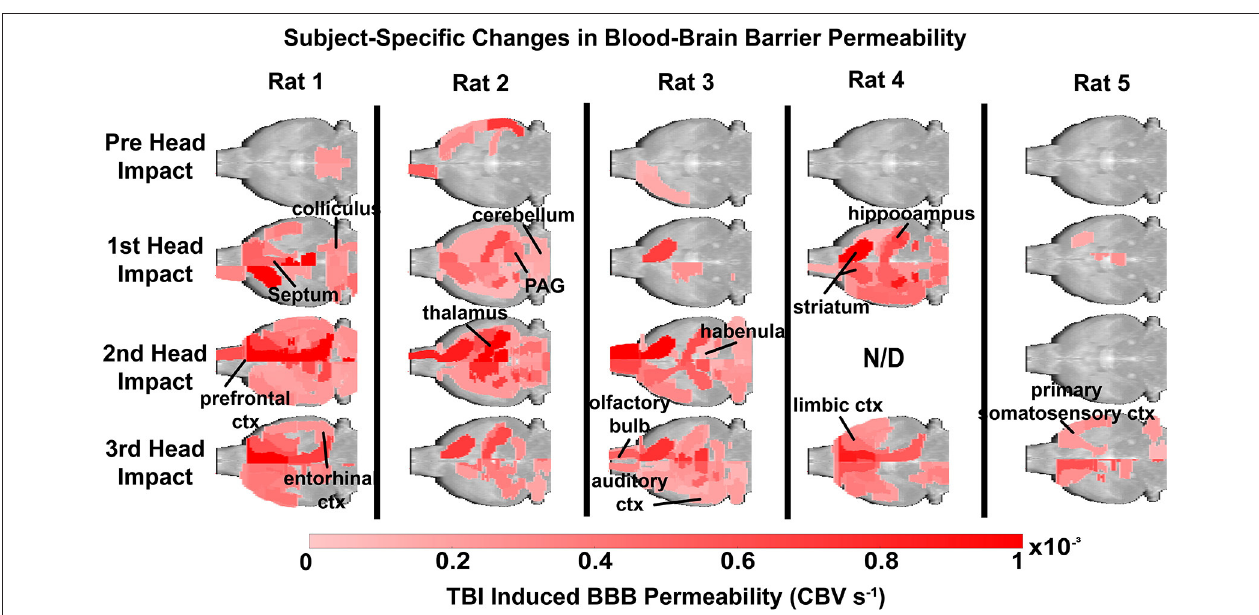
FIGURE 2 | Subject site-specific changes in blood brain barrier permeability. Each animal was scanned at baseline and following mild head impacts (1/day). Significance was determined by a linear regression model to assess the slope over the course of each imaging session, and then adjusted with a Bonferroni correction. Notably, increased BBB permeability was found near the site of impact. The color scale represents the slope and is only displayed if significant ( p < 0.1, FDR = 0.1).